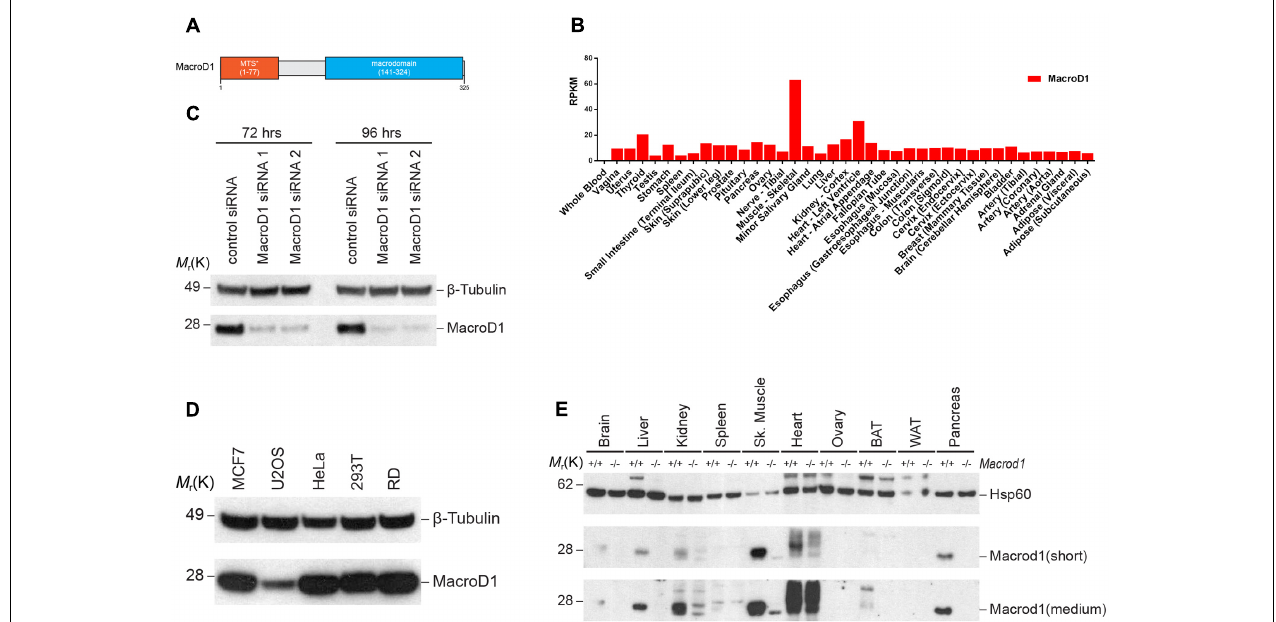
FIGURE 1 | MacroD1 is differentially expressed in human and mouse. (A) Schematic diagram of human MacroD1 macrodomain. MTS ∗ – predicted mitochondrial targeting sequence using MitoProt II – v1.101 (Claros and Vincens, 1996). (B) RNA-seq analysis of MacroD1 (red) mRNA transcript levels in human tissues. Data from GTEx (http://www.gtexportal.org). Data shown as median mRNA transcript levels. RPMK – reads per kilobase per million mapped reads. (C) Immunoblot analysis of MacroD1 steady state protein levels in HeLa cells following 72 or 96 h MacroD1 gene silencing by control siRNA, MacroD1 siRNA 1 or MacroD1 siRNA 2. (D) Immunoblot analysis of MacroD1 steady state protein levels in human cell lines. (E) Immunoblot analysis of Macrod1 steady state protein levels in tissues from Macrod1 + / + and Macrod1 − / − mice. BAT, brown adipose tissue; WAT, white adipose tissue; short, short exposure time; medium, medium exposure time.